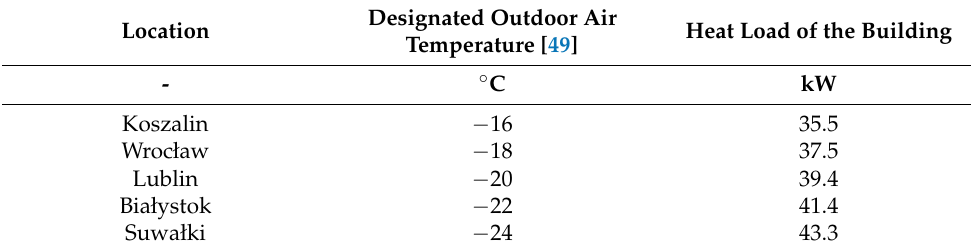
Table 3. Internal gains, determined based on [52].